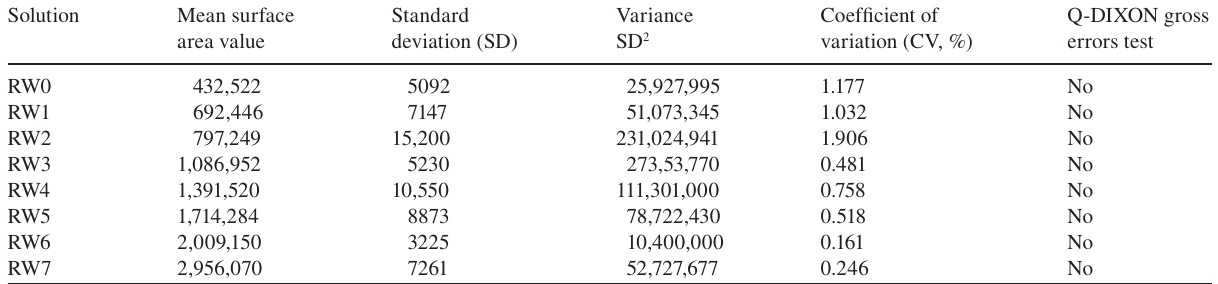
Table 3 The values of mean peak surface areas for samples of the investigated standard working solutions together with selected statistics. Solution